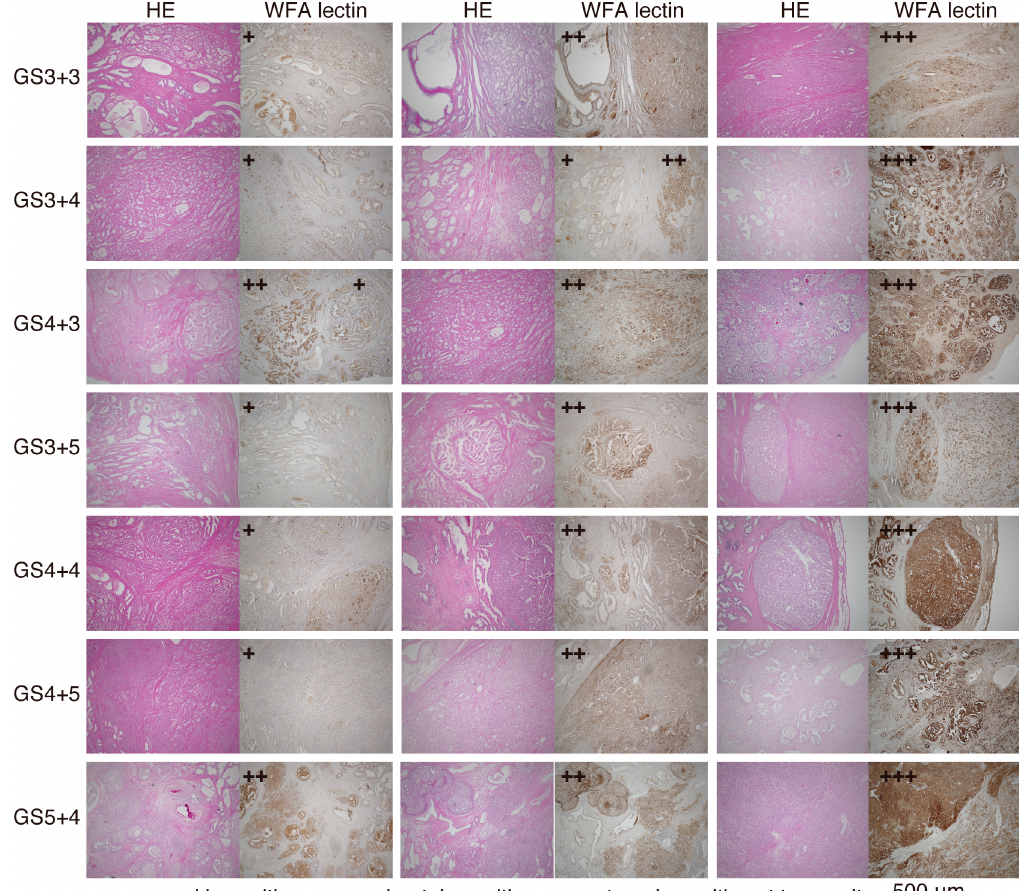
Figure A1. Representative hematoxylin-eosin (HE) staining and WFA reactive-glycan expression of tumors of each Gleason grade among RP specimens. WFA staining intensity was classified into three groups: weakly positive, moderately positive, and strongly positive at a tumor site, respectively. Scale bar indicated 500 μ m.